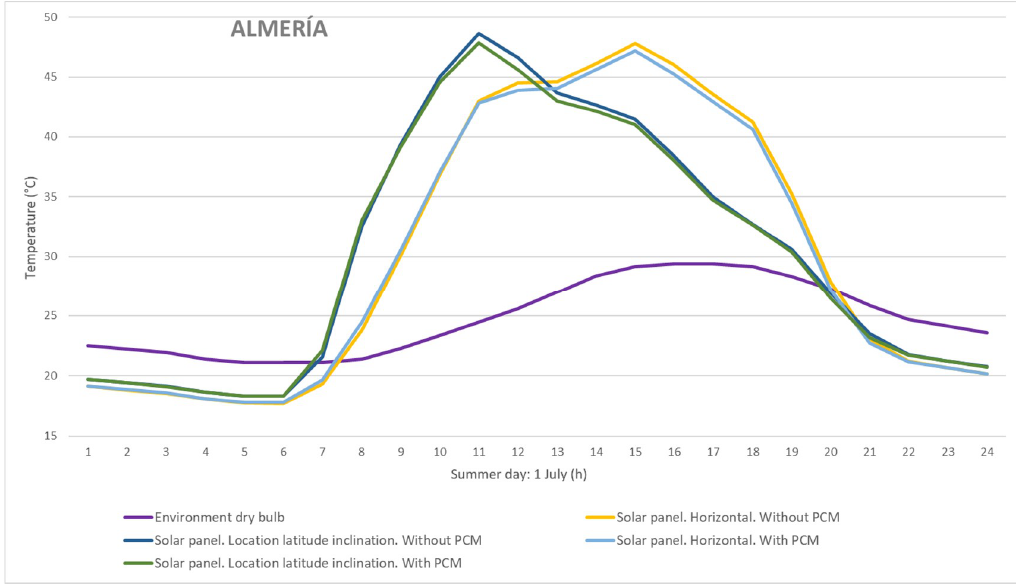
Figure 9. Estimated temperatures (°C) for a summer day in Almería.